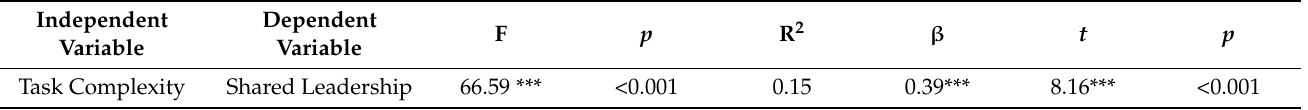
Table 4. Results of simple linear regression (H2).